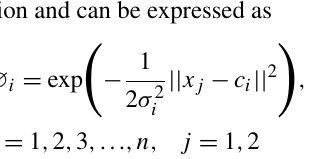
the arbitrariness in the number of hidden layers and the num- ber of neurons per hidden layer (Mahanty and Gupta,